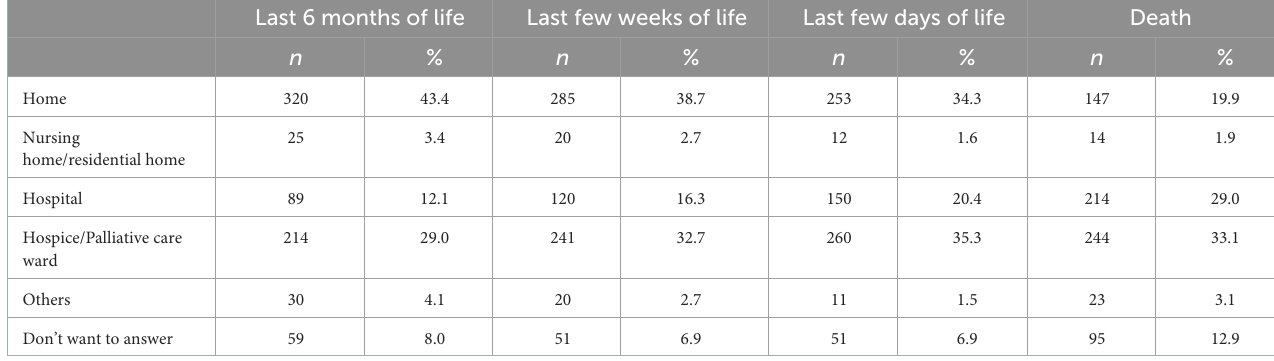
TABLE 2 Respondents’ preferred place of end-of-life care and death ( N = 737). Last 6 months of life